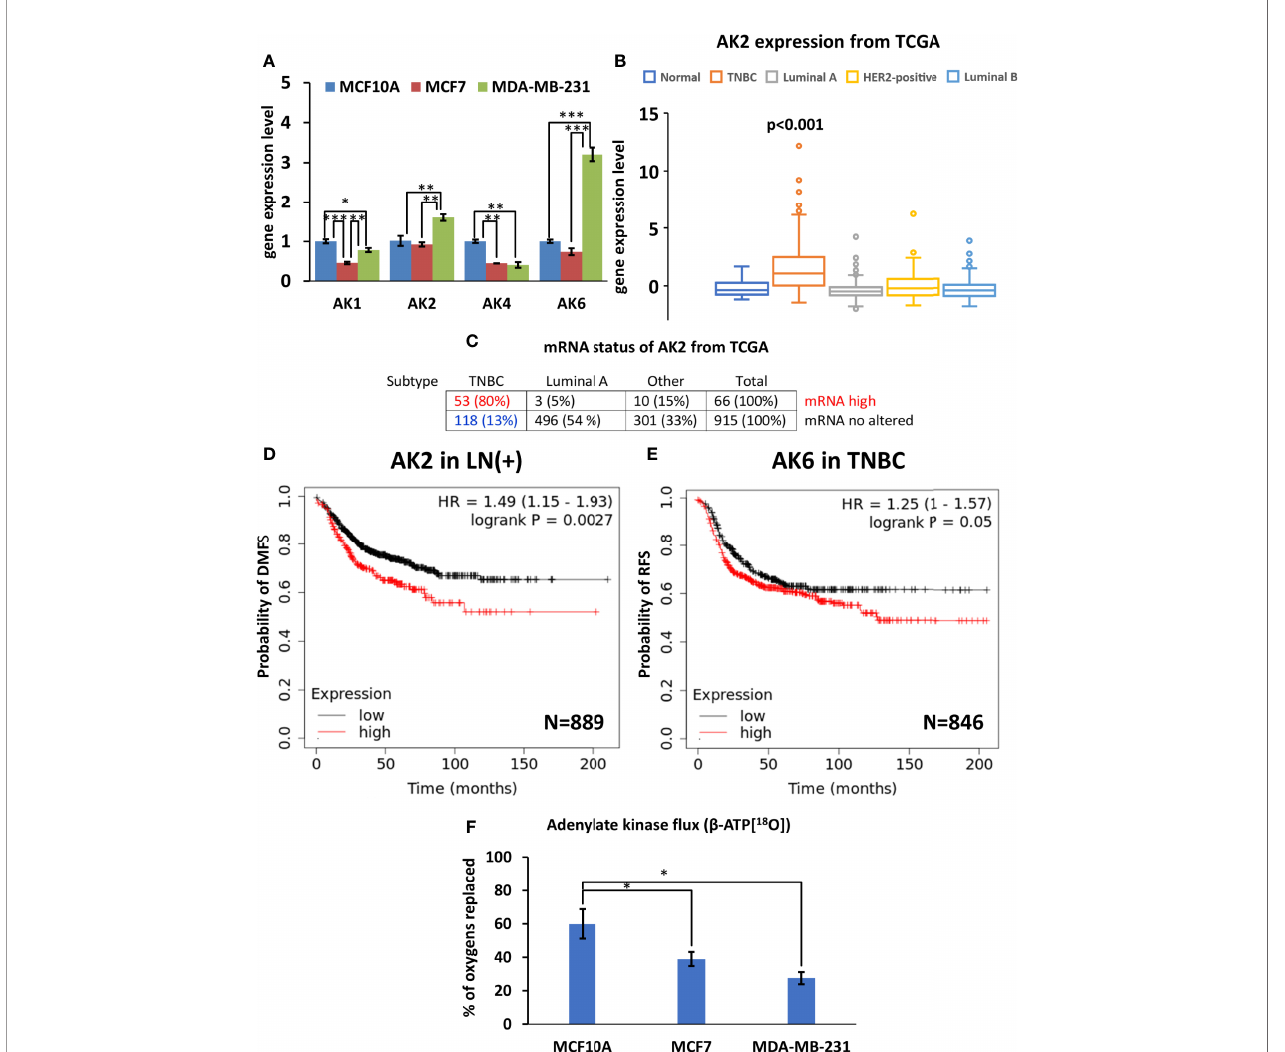
FIGURE 5 | Characterization of adenylate kinase (AK) network in Luminal A, Triple-negative breast cancer (TNBC) cells, and breast control cells. (A) Expression patterns of AK (fold change of the mRNA level) isoforms in Luminal A (MCF7), Triple-negative (MDA-MB-231) breast cancer, and control cells (MCF10A). The Cancer Genome Atlas (TCGA) database was utilized to analyze (B) AK2 expression patterns (ANOVA followed by Holm-Sidak test) and (C) mRNA status in different breast cancer subtypes. Kaplan-Meier survival analysis showing the relationship between (D) AK2 mRNA expression and distant metastasis-free survival (DMFS) in lymph node-positive (LN(+)) breast cancer patients, and the relationship between (E) AK6 mRNA expression and recurrence-free survival (RFS) in TNBC patients. (F) 18 O- metabolic labeling of b -ATP[ 18 O], re fl ecting AK fl ux. (D, E) Statistical analysis was performed using the Log-rank test. (A, F) are presented as mean ± SEM (ANOVA followed by Holm-Sidak test n=3-5). *, ** and *** indicate statistically signi fi cant differences between the mean values; p < 0.05,p < 0.01, and p < 0.001,